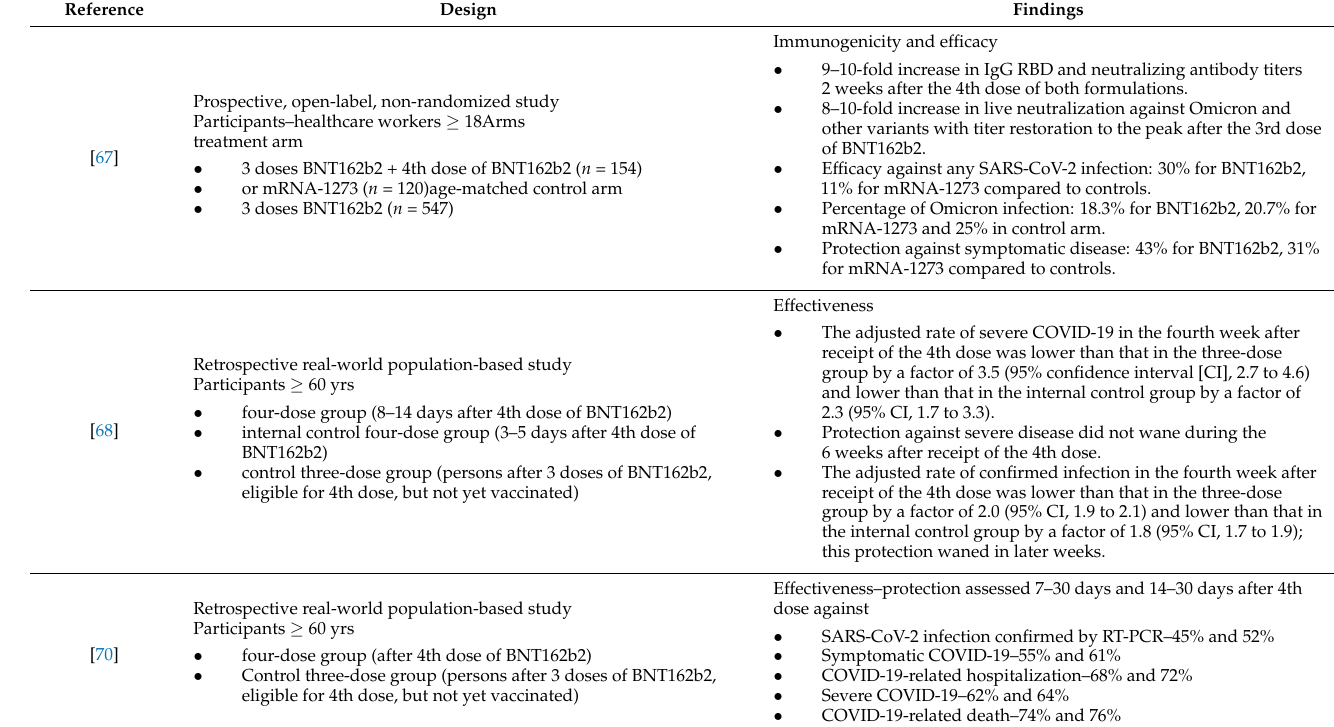
Table 3. Summary of studies evaluating immunogenicity and efficacy/effectiveness of the second booster of COVID-19